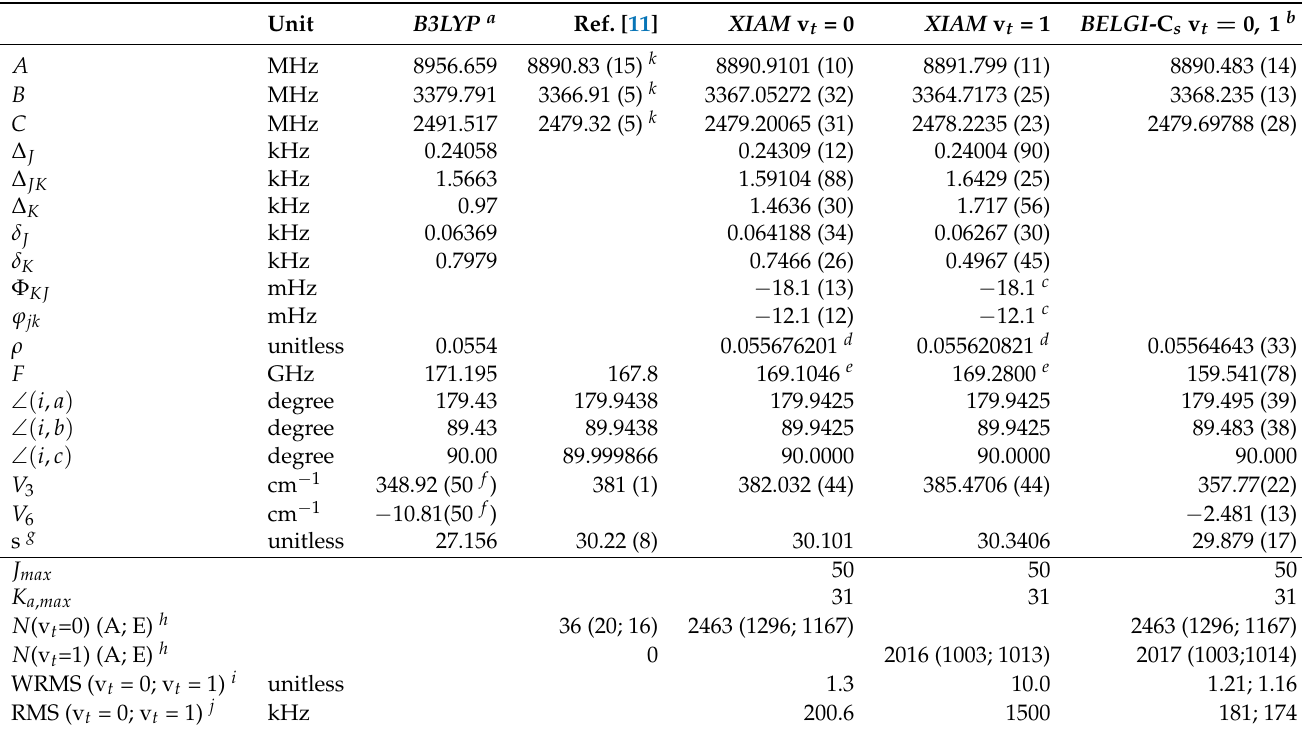
Table 2. Torsion-rotation constants of the 3-MF obtained from the mm-wave (70–220 GHz) analysis using the XIAM code for v t = 0 and v t = 1 separately, and BELGI -C s with a global fit analysis. These values are compared with quantum chemistry calculations (B3LYP method) and with the microwave analysis performed by Ogata et al. [11]. The numbers in parentheses represent 1 σ standard deviation in units of the last significant digit. All parameters are in the principal axes